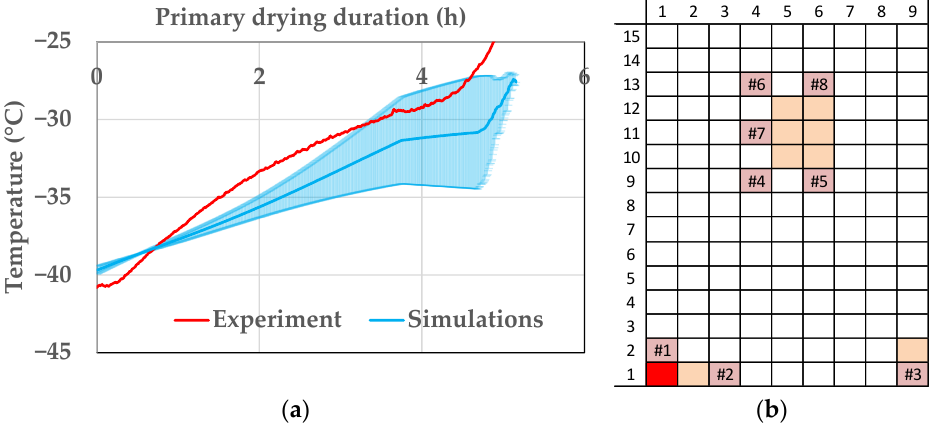
Figure 15. ( a ) Product temperature profile of vial 1.1 during primary drying at ++ −− . ( b ) Vial position (red: shown vial, orange: other probed vials, pink: WTMplus sensor position and WTMplus number).